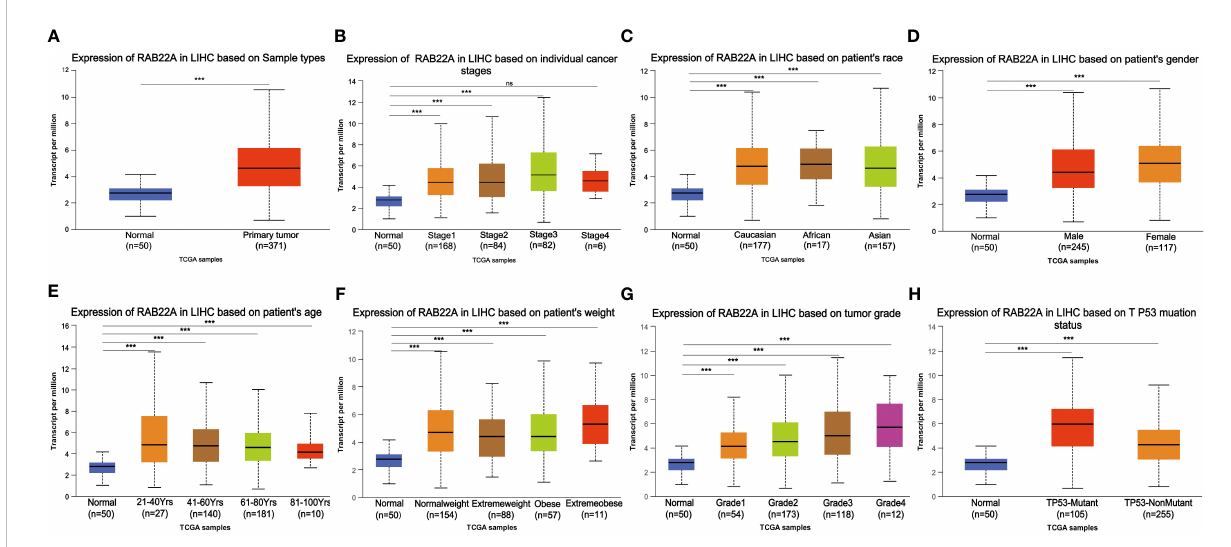
FIGURE 2 Box plot showing the relative transcription of RAB22A in individual cancer stages, race, gender, age, weight, tumor grade, and TP53 mutation status in a subgroup of patients with HCC. (A) RAB22A in normal and HCC tissues. (B) RAB22A in normal individuals or in patients with stages 1 – 4 liver cancer. (C) RAB22A in normal and LIHC samples based on patient ethnicity. (D) RAB22A in normal individuals and males and females with HCC. (E) RAB22A in healthy subjects of any age and patients aged 21 – 40, 41 – 60, 61 – 80, and 81 – 100 years with HCC. (F) RAB22A in healthy subjects of any weight and normal weight patients, extreme weight patients, obese patients, and extremely obese patients. (G) RAB22A in normal subjects and patients with different liver cancer tumor grades. (H) RAB22A in normal and TP53-mutant or TP53-non mutant patients. * p < 0.05, ** p < 0.01, *** p < 0.001, NS, no signi fi